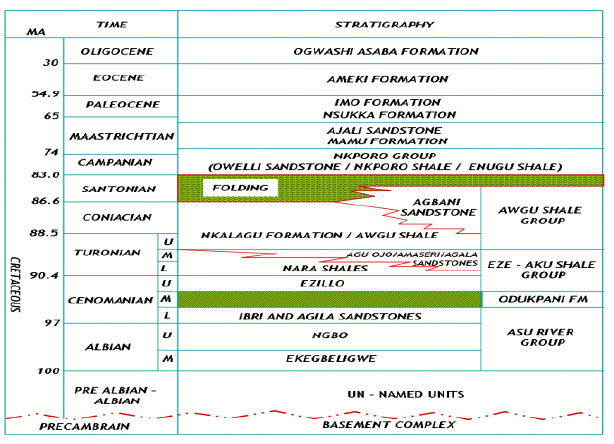
Figure 2: Map of the Study Area.